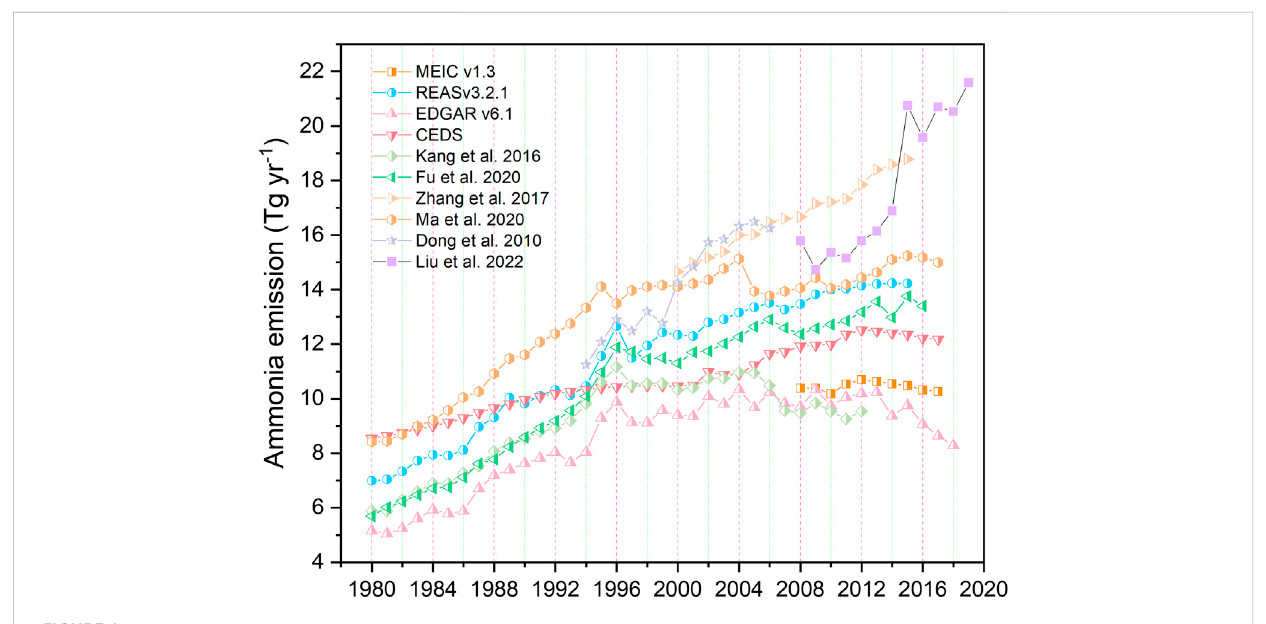
Comparison of ammonia emissions in China from ten published results and datasets.